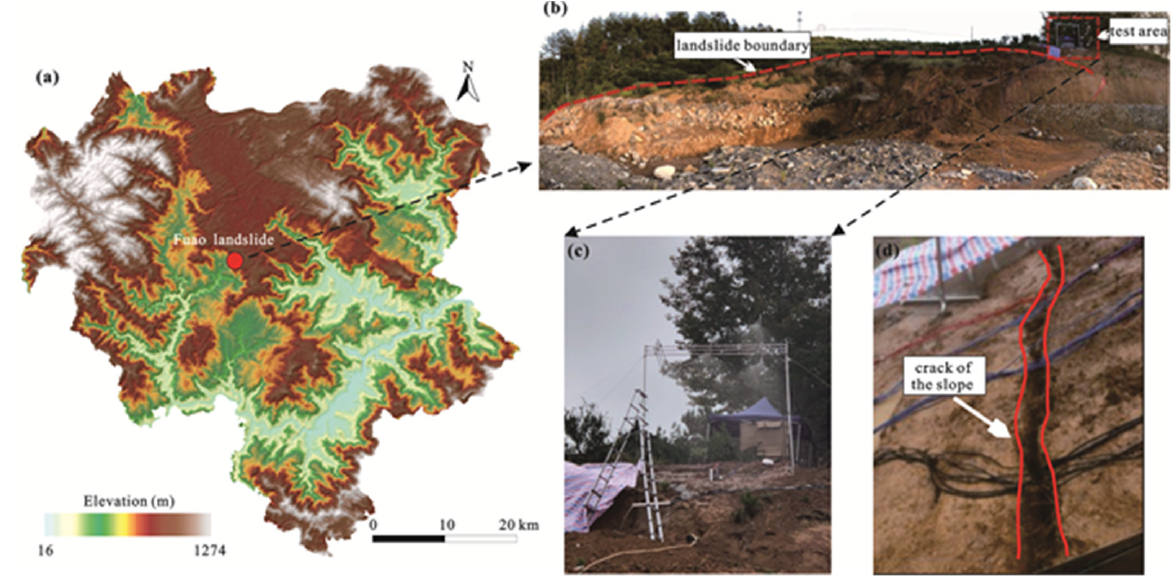
Figure 1. Location of the study area and the overall characteristics of the landslide in Fu’ao Village: ( a ) Digital elevation model (DEM) of Wencheng County, Wenzhou City; ( b ) Photo of the landslide in Fu’ao Village; ( c ) Photo of the experimental site; ( d ) Fracture at the rear of the landslide.